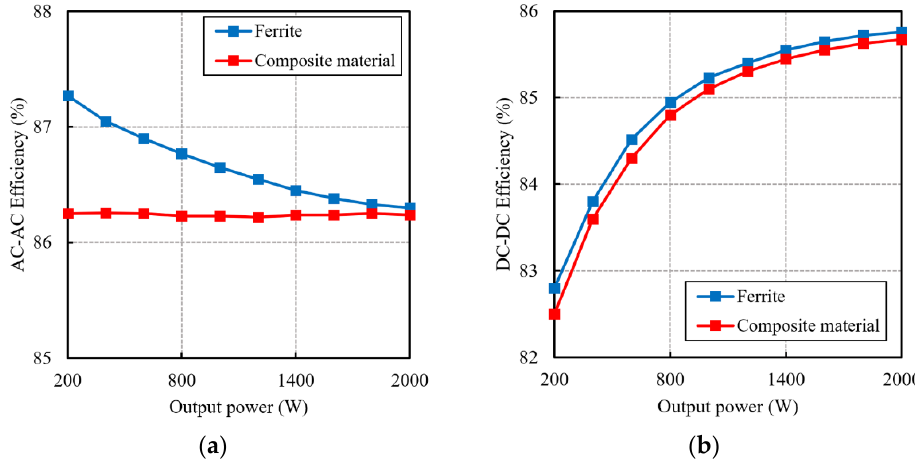
Figure 14. Efficiency measurements: ( a ) inter-coil efficiency and ( b ) overall efficiency of the system.